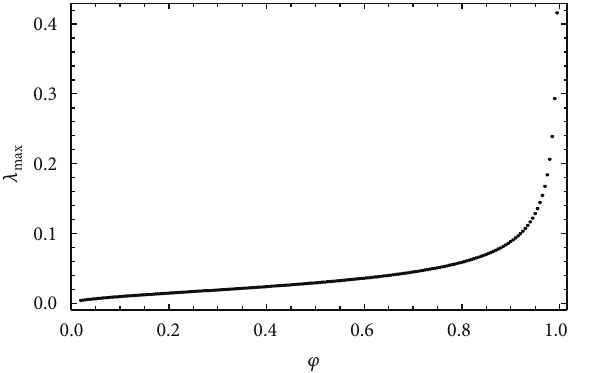
Figure 5: : Variation law of 𝜆 max versus 𝜑 for 𝑑 = 0.041 .